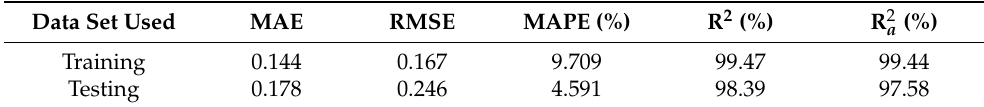
Table 8. Metric used for cross-validation and evaluation of the accuracy of the model. Data Set Used